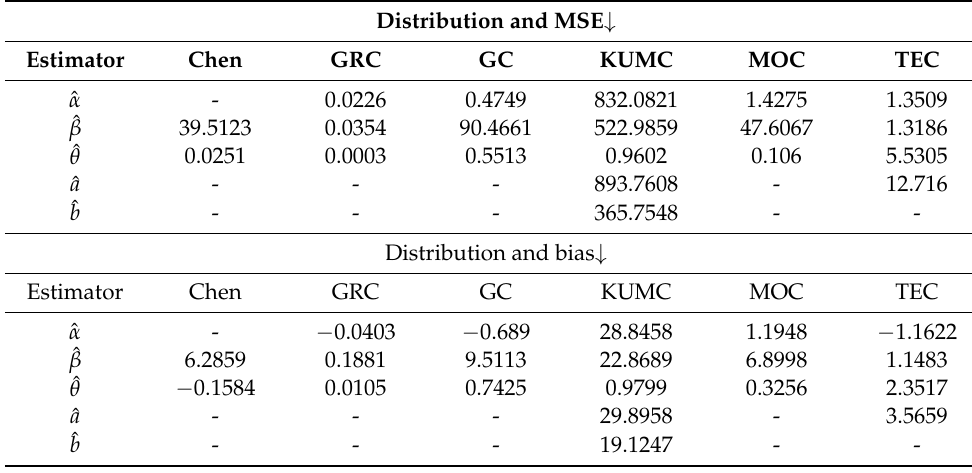
Table 15. Results for samples generated from the GRC distribution with n = 500.